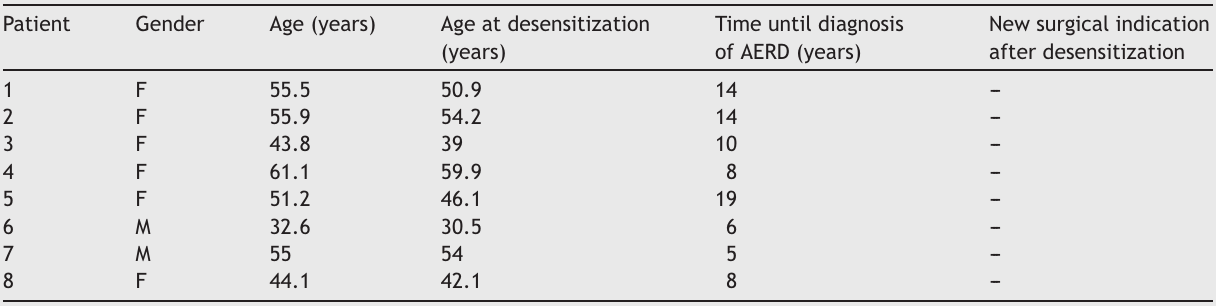
Patients who completed ASA desensitization.